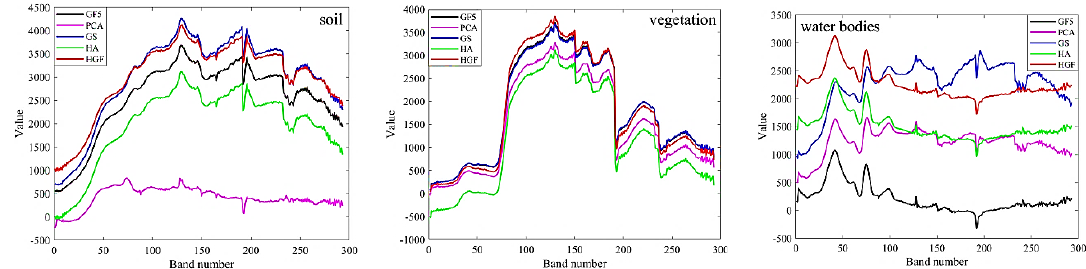
Figure 5. Land cover spectral information using different fusion methods. Table 2. Fusion accuracies.